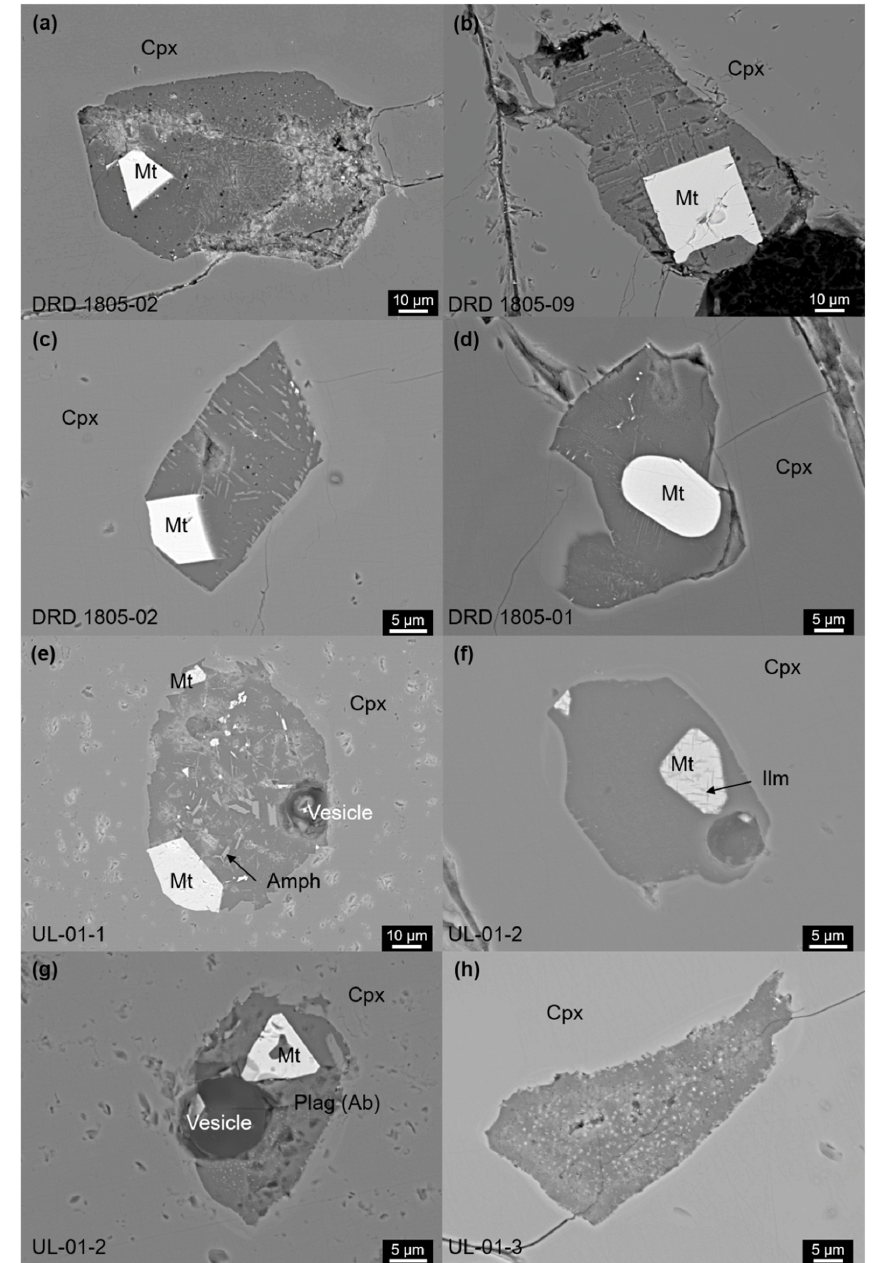
Figure 3. Backscattered-electron (BSE) images of crystallized melt inclusions hosted in clinopyroxene of trachyte from ( a – d ) Dokdo and ( e – h ) Ulleung islands. Mt: Ti-magnetite; Amph: amphibole; Cpx: clinopyroxene; Plag: plagioclase; Ilm: